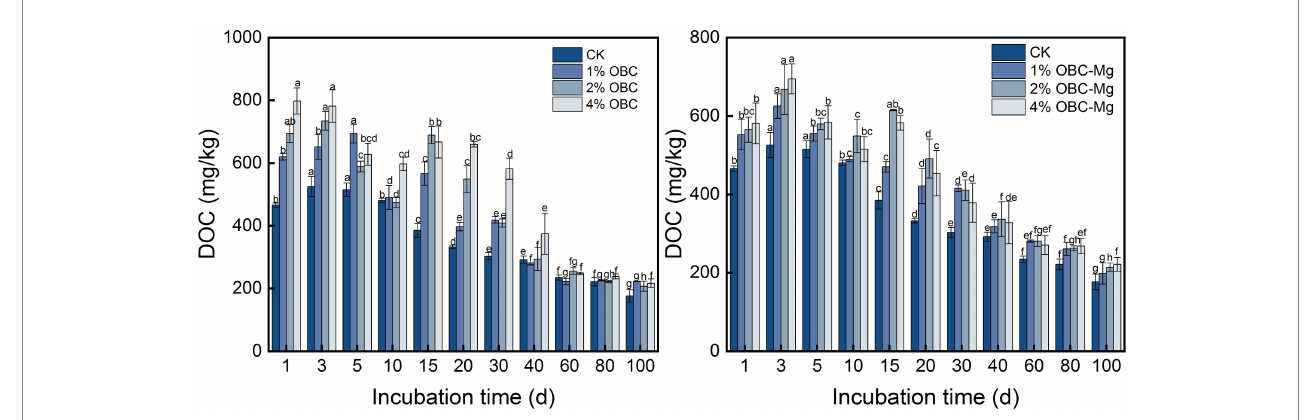
FIGURE 10 Changes in dissolved organic carbon (DOC) after the amendment of OBC and OBC-Mg.